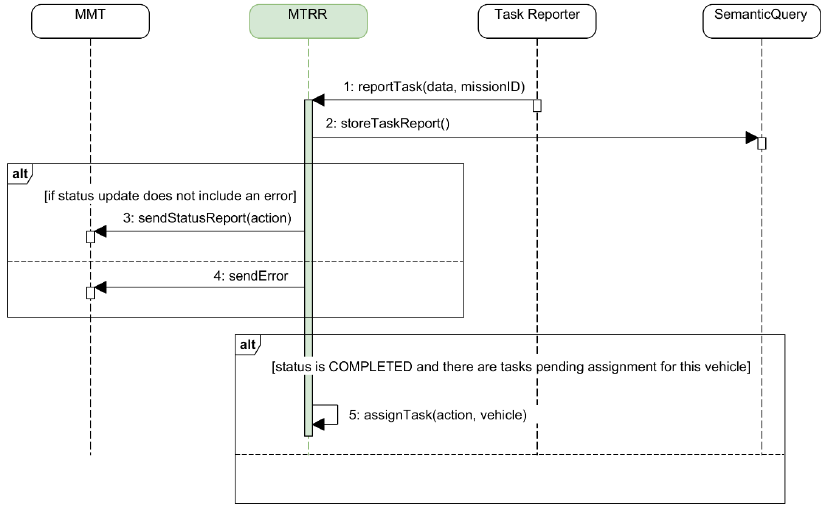
Figure 17. Sequence diagram for the task report method in the MTRR.